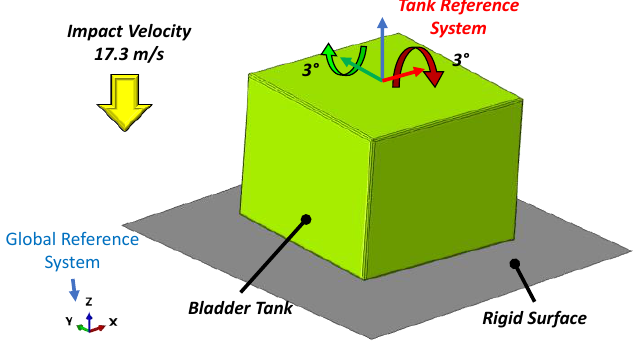
Figure 3. Boundary Figure 3. Boundary conditions. Figure 3. Boundary conditions.